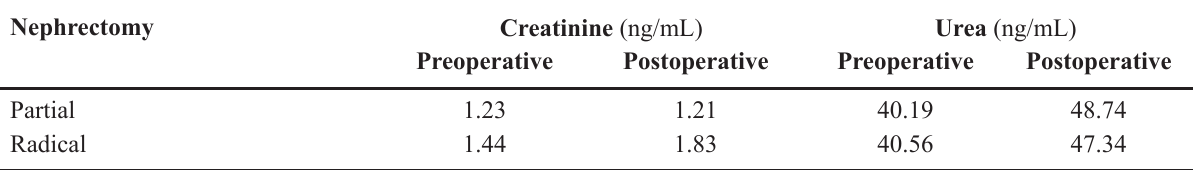
Table 6 – Hematological analysis pre and